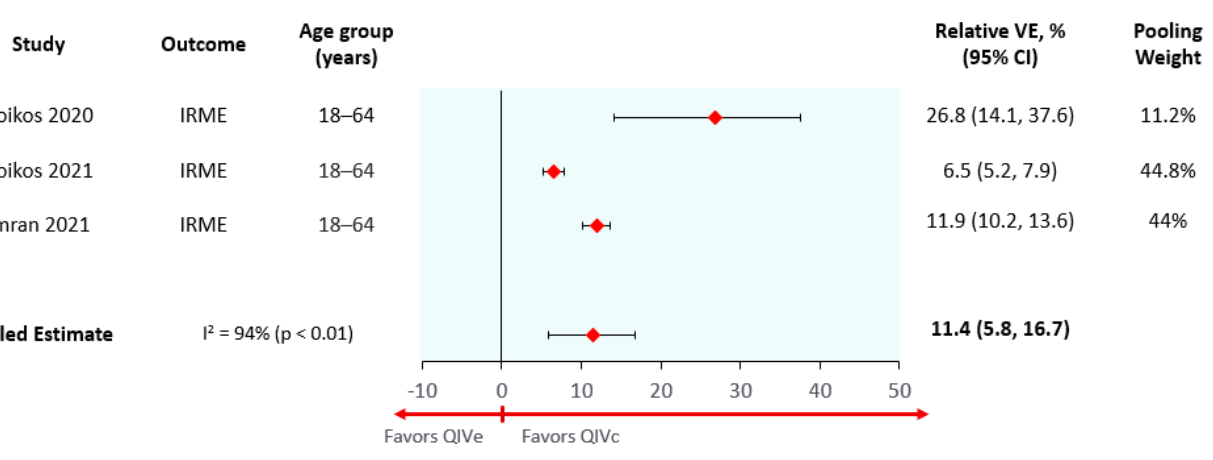
Figure 3. Meta-analysis of QIVc vs. QIVe, prevention of influenza related medical encounters in adult population.IRME: influenza-related medical encounters; VE: Vaccine Effectiveness; QIVe: Egg-based Quadrivalent Influenza Vaccine; QIVc: Cell-based Quadrivalent Influenza Vaccine.